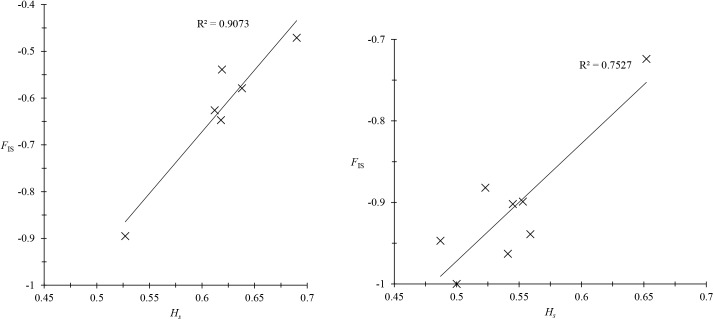
Regression between F
IS, inbreeding index of individuals relative to subpopulations per locus, and Nei's unbiased estimator of genetic diversity H
s [52] in Trypanosoma brucei gambiense 1 [19] in West Africa [12] and Central Africa [23].The proportion of variance explained by the model (R
2) and the corresponding p-values are indicated.